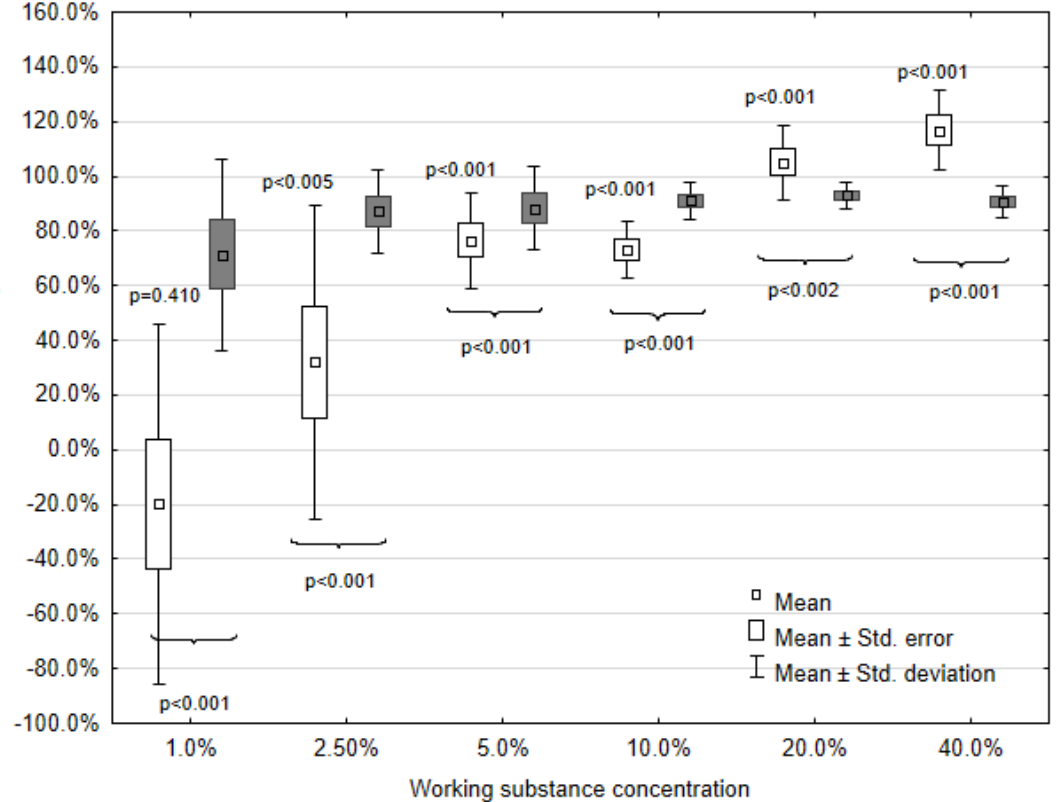
Figure 2. Impact of ethanol extract of propolis (EEP, white color) and ethanol (EtOH, grey color) on the metabolic activity in P. mirabilis ; p -values on the boxplot above whiskers refer to the EEP and positive control comparison; p -values below whiskers refer to the EEP and EtOH comparison.